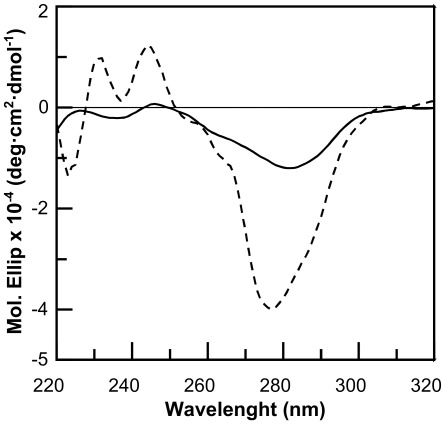
CD of single strands.CD spectra of PNA S (–) and PNA OH (–) in 10 mM Phosphate buffer 100 mM NaCl, 5 mM MgCl2, pH 7 at 10 µM strand concentration.